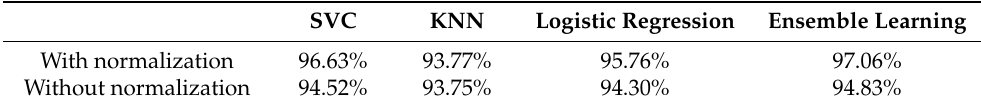
Table 2. Effect of data normalization on the results of the different algorithm models. SVC KNN Logistic Regression Ensemble Learning With normalization 96.63% 93.77% 95.76% 97.06% Without normalization 94.52% 93.75% 94.30%